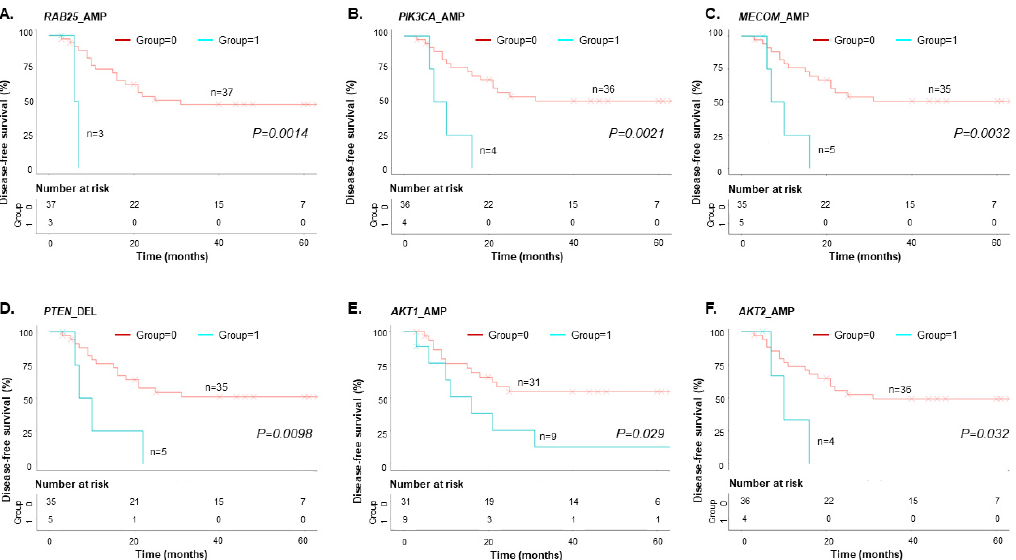
Figure 3. Kaplan–Meier analysis for EOC patient DFS (n = 40). ( A ) RAB25 amplification ( RAB25 _AMP), ( B ) PIK3CA_AMP , ( C ) MECOM _AMP, ( D ) PTEN deletion ( PTEN _DEL), ( E ) AKT1 _AMP, and ( F ) AKT2 _AMP had a significantly worse DFS ( p < 0.05, log-rank test). OS analysis was performed using the following 0/1 grouping information: 0 = EOC patients who were alive; 1 = EOC patients who died. Three EOC patients were not availa- ble for follow-up. Therefore, only 37 of 40 EOC patients were analyzed (Table S1). Three of the thirty-three genes from the TCGA dataset ( DPH1 , ERBB2 , and NOTCH3 ) were ex- cluded because none of the EOC patients harboring CNVs in these genes died during the follow-up period. We found four genes with CNVs ( RAB25 , DAB2 , TP53 , and RPS6KA2 )